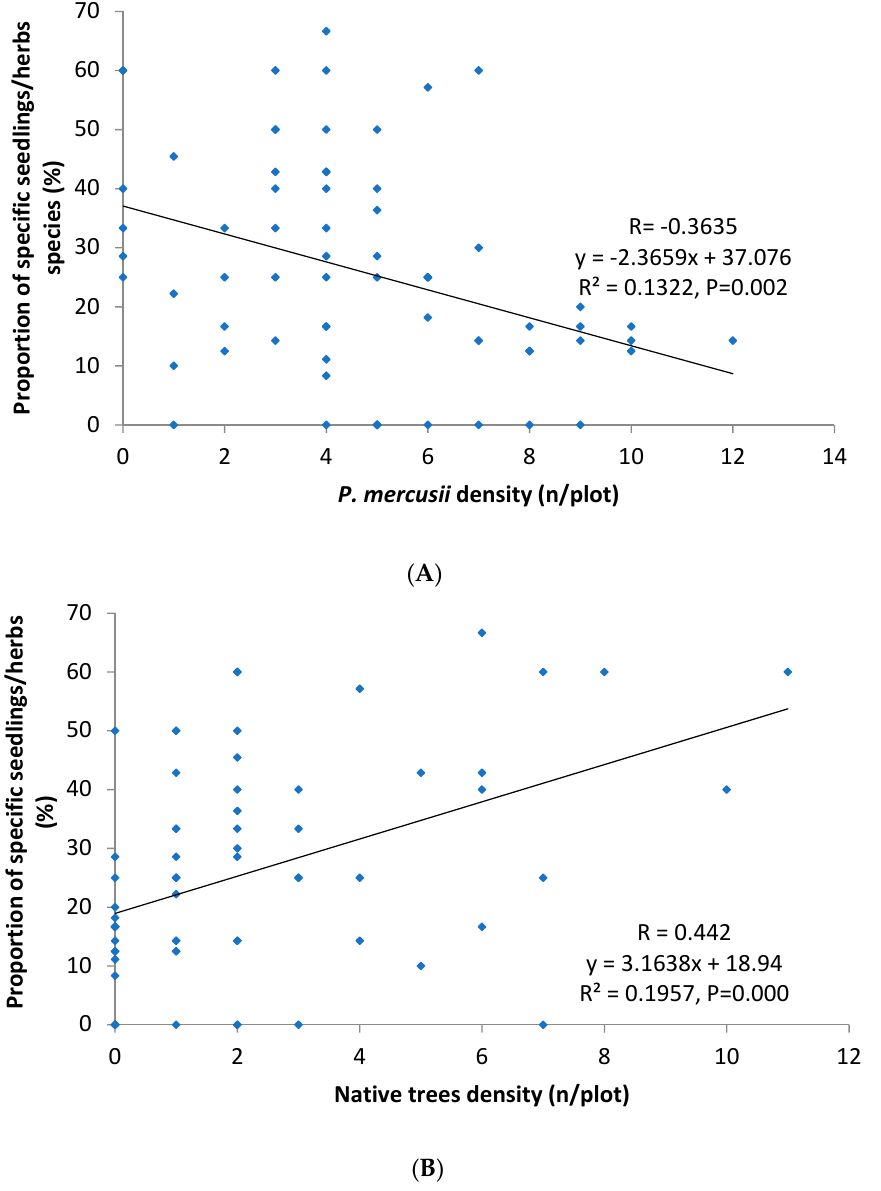
Figure 4. Relationship between tree density (number of individual trees) and the proportion of specific species around water source areas at the seedling/herb level ( A = Pinus merkusii , B = Native trees)